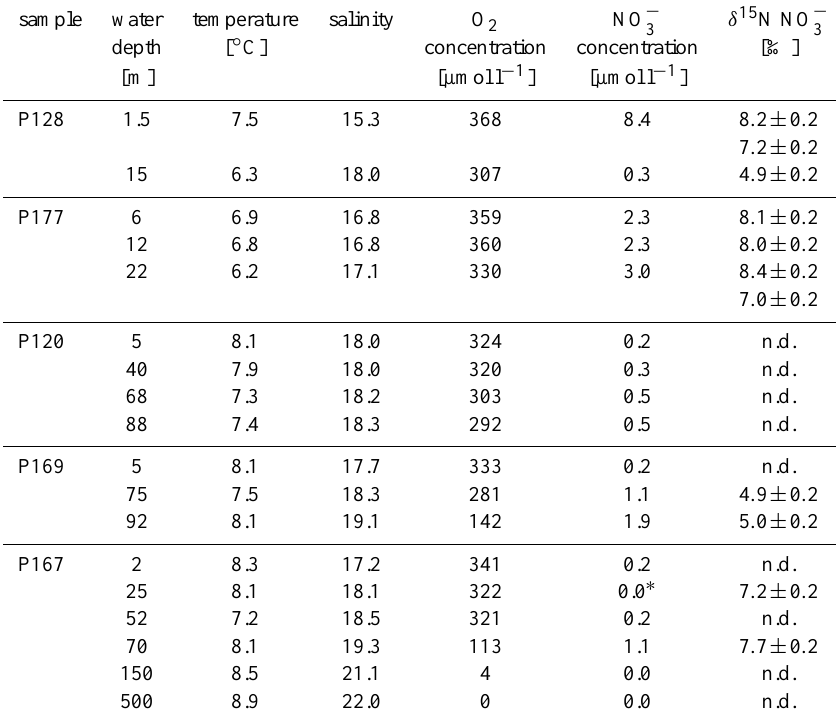
Table 2. Seawater chemical properties and nitrate nitrogen isotopic composition. n.d. = not